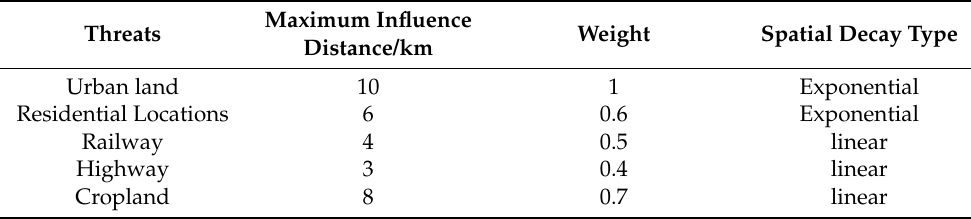
Table 2. Maximum influence distance and weight of the threat factors.